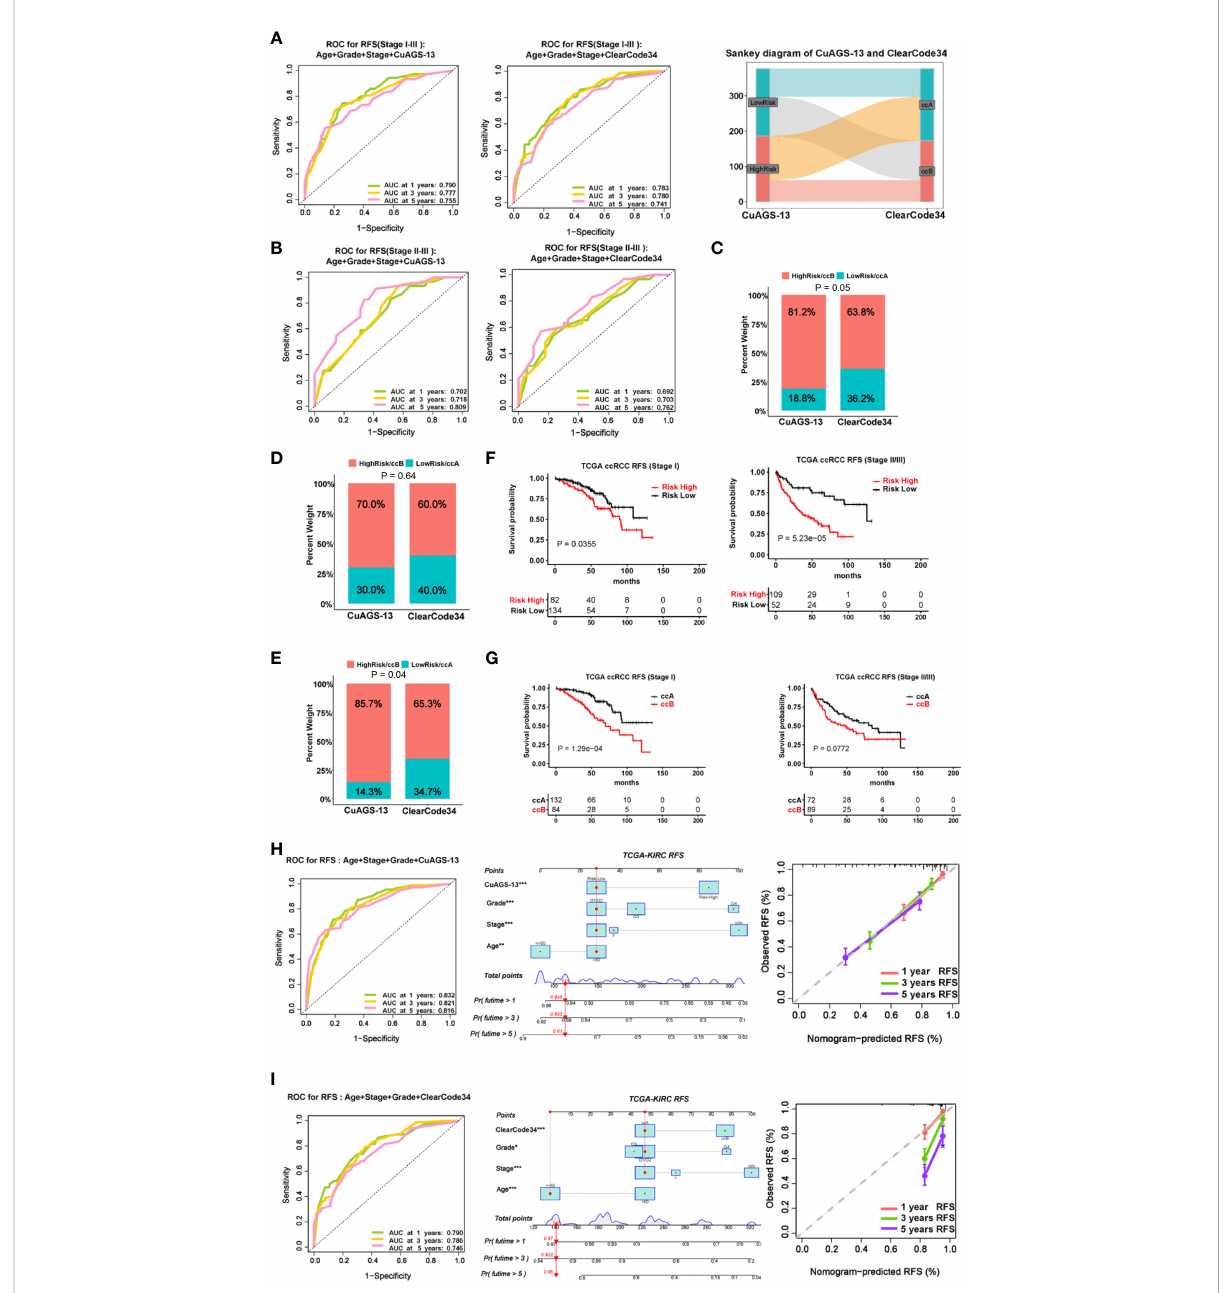
FIGURE 4 Comparison of predictive powers for recurrence and recurrence-free survival (RFS) between the CuAGS-13 and ccAccB/Clearcode34 models. (A) The ROC curve showing accuracy in predicting 1-, 3- and 5-year RFS for patients at stage I – III using CuAGS-13 (Left) and Clearcode34 (Middle) models. Right: The Sankey diagram showing different patient groups classi fi ed the CuAGS-13 and ccAccB/Clearcode34 models. (B) Left: The ROC curve showing accuracy in predicting 1-, 3- and 5-year RFS for patients at stage II – III using CuAGS-13 (Left) and ccAccB/Clearcode34 (Right) models. (C) : C-index analysis showing higher sensitivity of CuAGS-13 than Clearcode34 models for predicting recurrence in all patients at stage I – III. (D) C-index analysis showing no signi fi cant differences by CuAGS-13 and Clearcode34 models for predicting recurrence in patients at stage I (E) C-index analysis showing higher sensitivities of the CuAGS-13 than Clearcode34 models for predicting recurrence in stage II-III patients. (F, G) Kaplan – Meier survival analysis showing RFS predictive powers of CuAGS-13 (F) and Clearcode34 (G) models in patients at stage I and stage II – III, respectively. (H) The CuAGS-13 model-based nomogram for predicting 1-, 3- and 5-year RFS in TCGA ccRCC patients (stage I – IV). (I) The ccAccB/Clearcode34 model- based nomogram for predicting 1-, 3- and 5-year RFS in TCGA ccRCC patients (stage I –